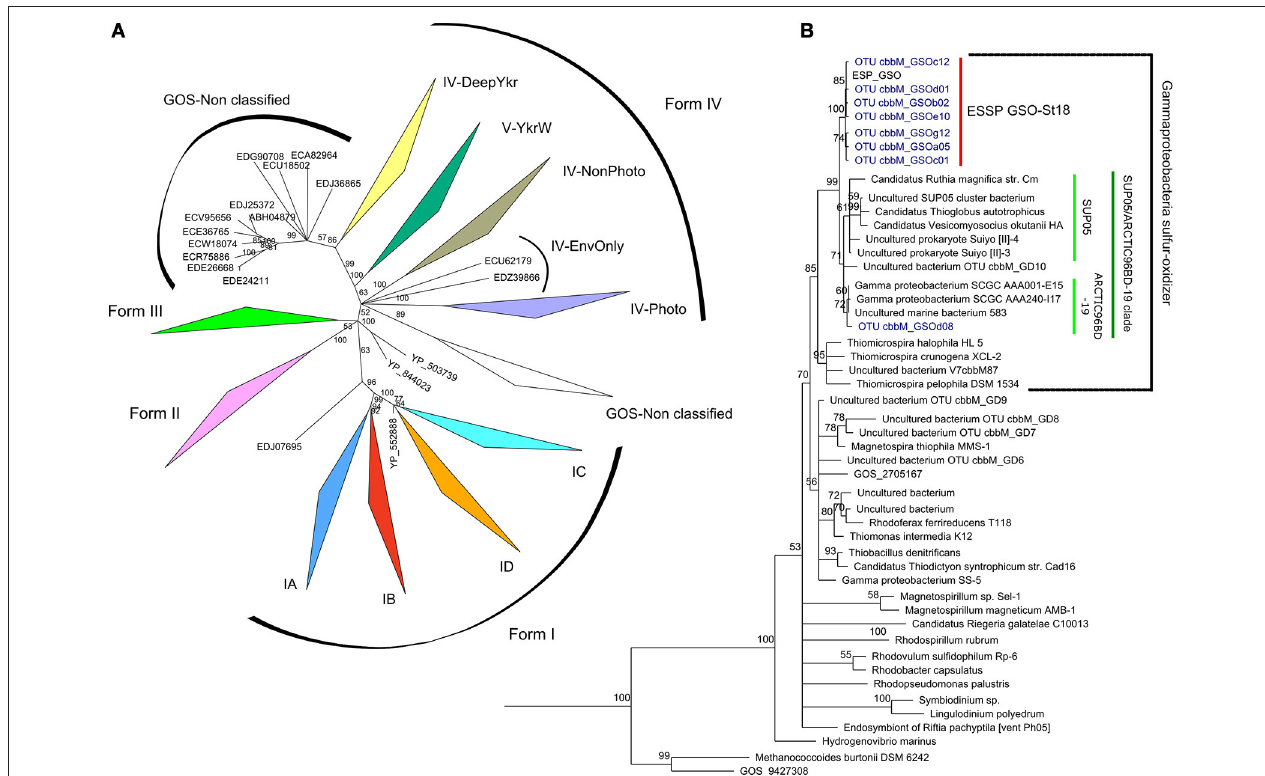
FIGURE 3 | Maximum-likelihood phylogenetic tree of RuBisCO. Panel (A) shows a phylogenetic tree based on aminoacid sequences from the four forms of RuBisCO enzyme described until today, the OTU sequences under study in this work were analyzed against this RuBisCO “database” and they could be clearly separated and structured in the branch of form II. Panel (B) shows the subtree for the form II (CbbM) of RuBisCO and the classification of the OTU sequences obtained in this study, in blue, forming a separated group denoted ESSP GSO-St18 and associated to the sequence from a previous metagenomics analysis ( cbbM , Contig14992) designed ESP_GSO, in black. One of the OTU sequence (GSOd08) is associated to the ARCTIC96BD-19 sequences. The tree was inferred using maximum likelihood implemented in PhyML. Bootstrap values higher than 50% are